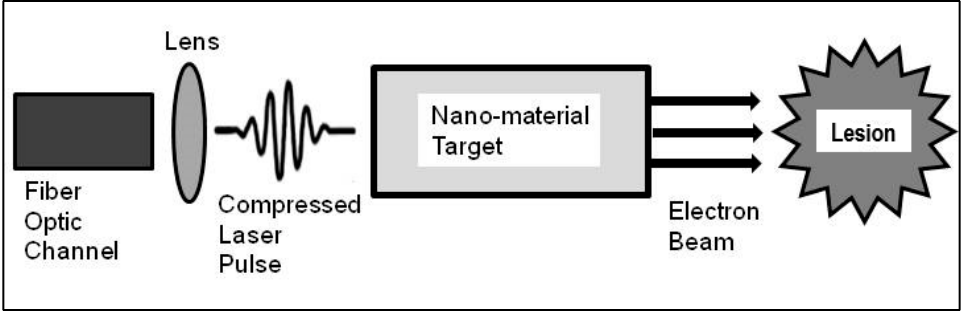
Figure 2. Schematic of a fiber optic channel and laser beam traveling through the fiber. At the end of the fiber, the laser enters a micro-lens which compresses the laser pulse prior to entering a high-density nano-tube fabric target. The target is near its critical density materials, which is the result of a nano-tube fabric spanned from a set of struts. An electron beam, produced from the LWFA interaction of the laser with a high-density target, is used for treatment. It is envisioned that the fiber optic channel, lens, and target cavity setup to be in the ~100 micron scale, and the electron beam could be aimed directly at a lesion volume.